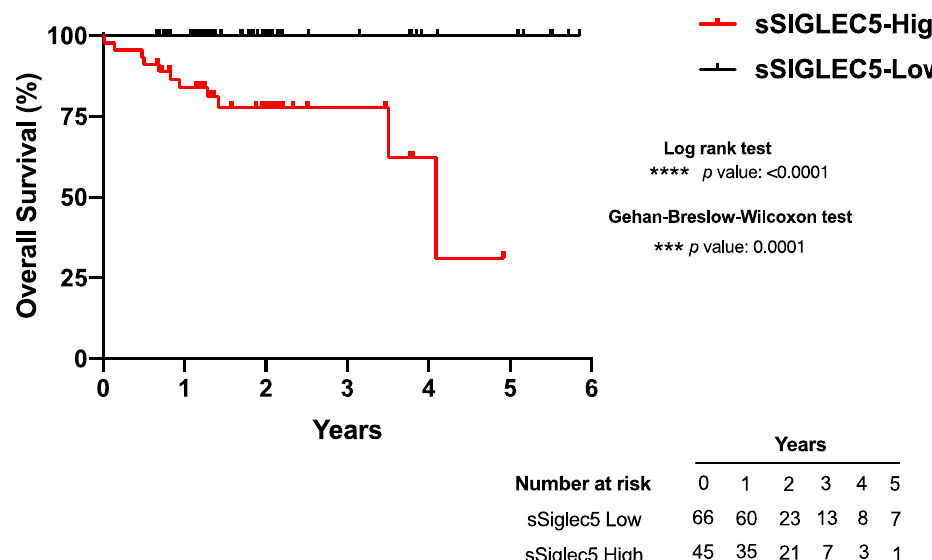
Figure 4. Pre-operative soluble SIGLEC5 levels predict survival of patients with colorectal cancer. Kaplan–Meier survival curve from surgery date to study end date, 7 April 2021, according to baseline plasma sSIGLEC5 is shown. The differences between survival rates associated with sSIGLEC5 were calculated by a log-rank (Mantel-Cox; p < 0.0001) test with 95% confidence interval. The Gehan–Breslow–Wilcoxon test also showed similar significance levels at early time points ( p = 0.0001). A p -value < 0.05 was used as the level of significance. ***, p < 0.001; ****, p < 0.0001